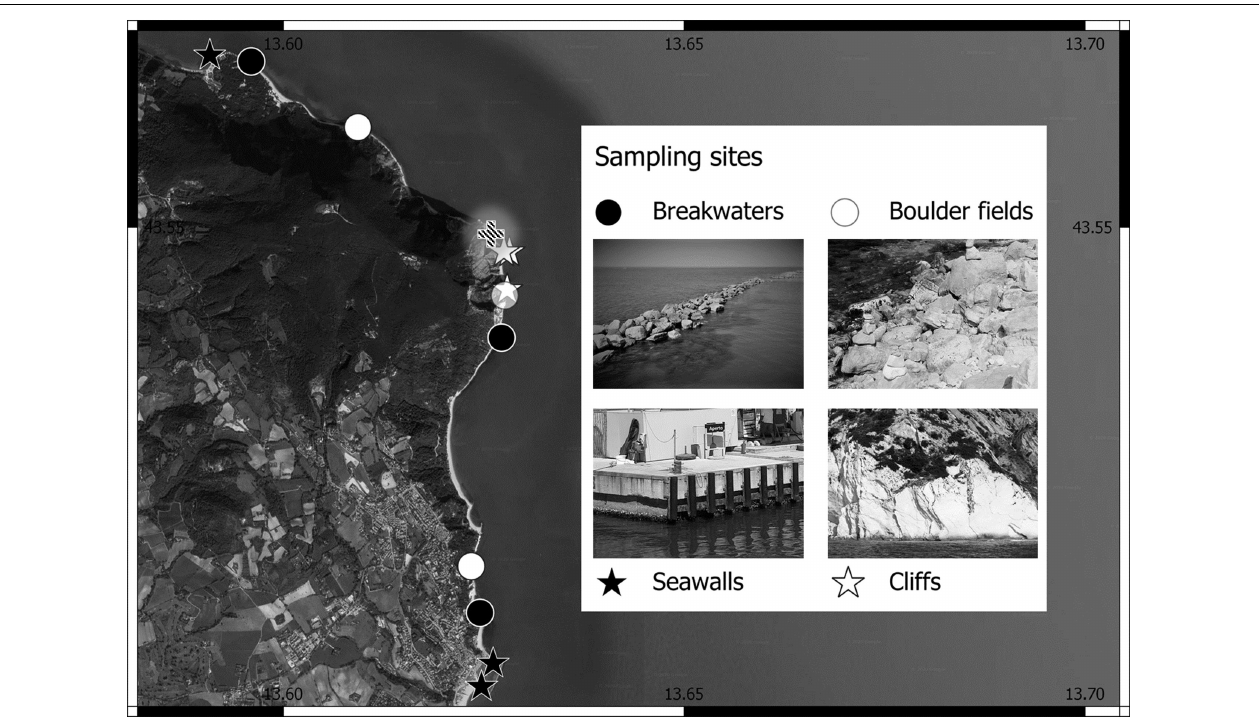
FIGURE 1 | Map with site locations for each combination of habitat Type (Artificial = black symbols, Natural = white symbols) and Morphology (Irregular = circle symbols, Regular = star symbols). The dashed cross represents the Due Sorelle site.